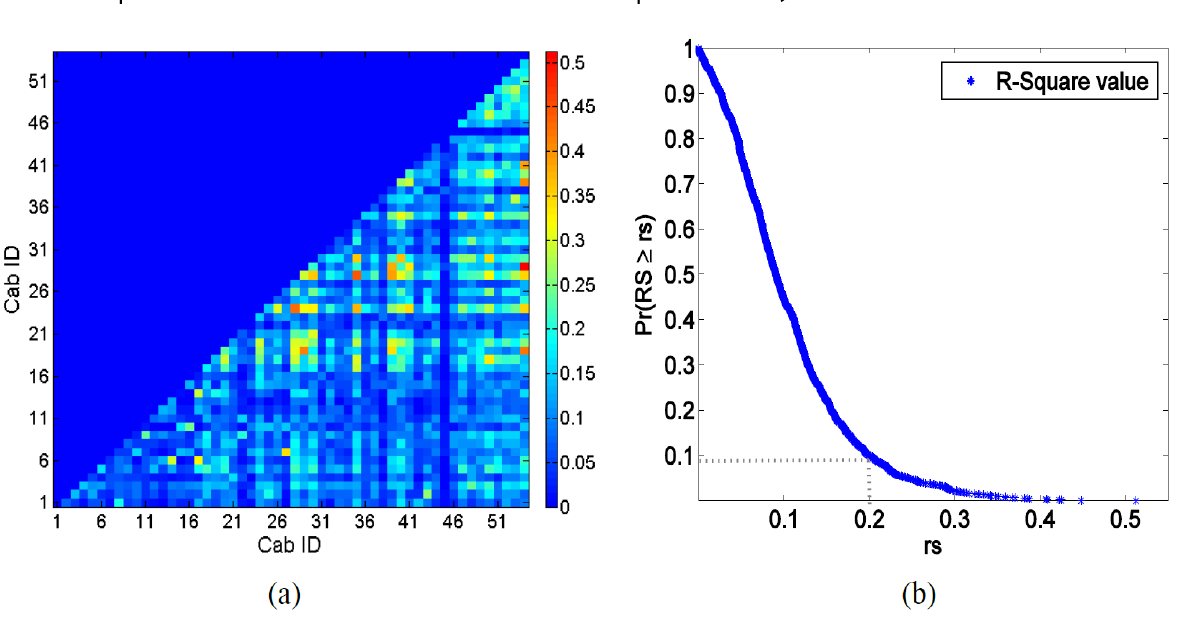
Figure 10. R-Square values for the pairs of taxicabs (Note: ( a ) shows image of R-Square values for every pair of taxicabs, where both x-axis and y-axis denote the taxicab ID; ( b ) is the empirical distribution function for all the R-Square